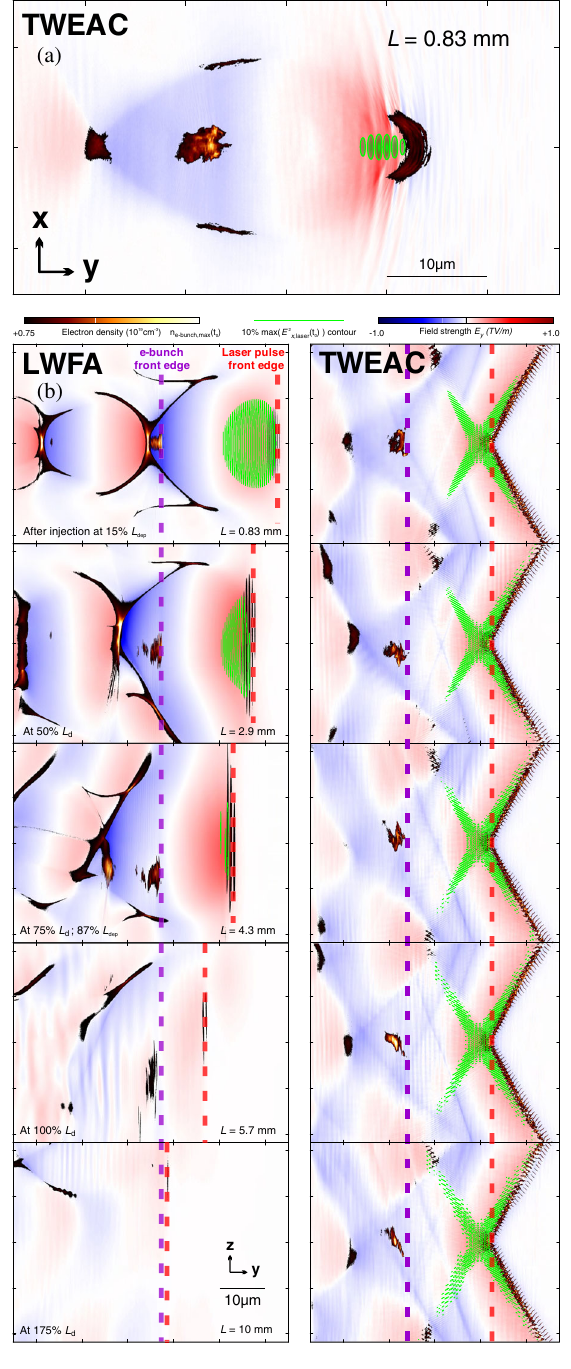
FIG. 3. Comparison of the laser, cavity, and electron bunch evolution of LWFA and TWEAC, at characteristic stages of interaction until the acceleration length 1 . 75 L , thus illustrating dep that quasistationary laser fields of TWEAC lead to continued electron acceleration. (a) The xy plane and (b) the yz plane. Each figure shows the respective accelerating cavity field E , electron y ¼ 0 . 75 × 10 19 cm − 3 , and laser field intensity density beyond n e contour ∝ E 2 at 10% of the maximum initial intensity. Two lines to x guide the eye mark the front edge of the electron bunch (purple) andthe rising edgeofthe laserpulse(red)duringacceleration,such that a decreasing separation highlights drive-laser